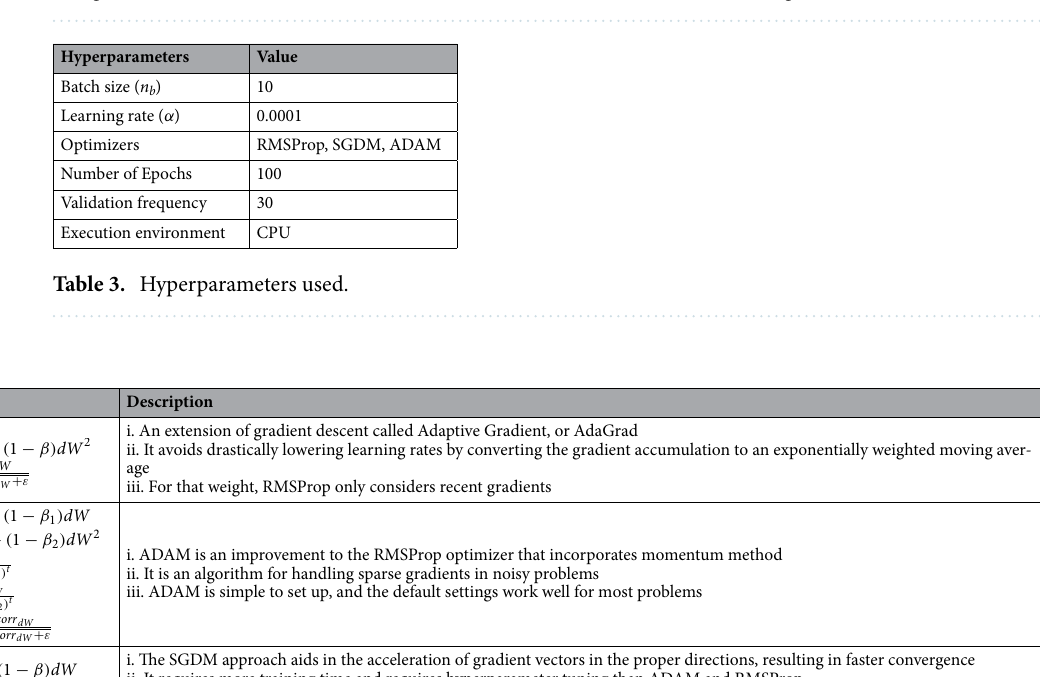
Figure 4. Modification of the Convolutional Neural Networks base architectures (viz: AlexNet, MobileNetV2, GoogLeNet and ResNet-50) from the conventional classification framework to a regression framework.